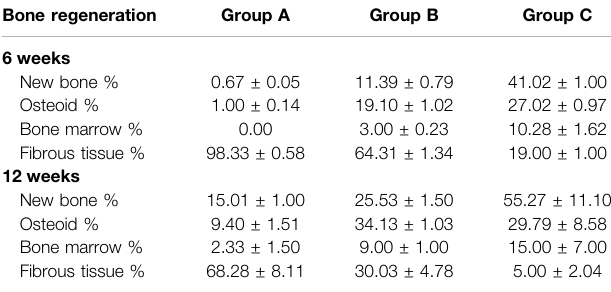
TABLE2| Histomorphometriresultsdemonstratingthemeanpercentagesofnew bone formation, osteoid, bone marrow and fi brous tissue in groups (group A (control), group B (chitosan gel), group C (OPG-chitosan gel)) at 6 and 12 weeks. Bone